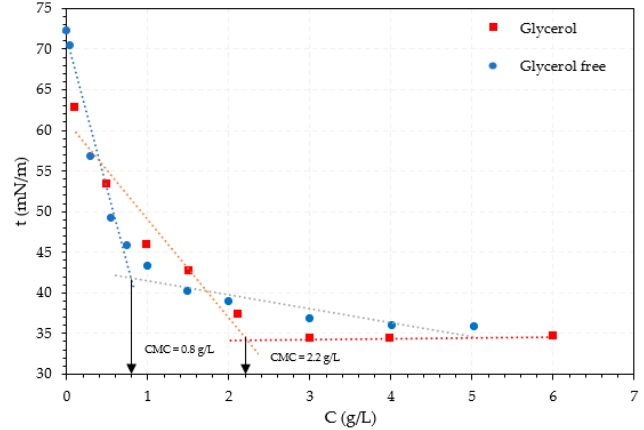
Figure 2. Critical micelle concentration (CMC) for saponified coconut oil (SCO) with and without glycerol, measured by maximum bubble pressure tensiometer.